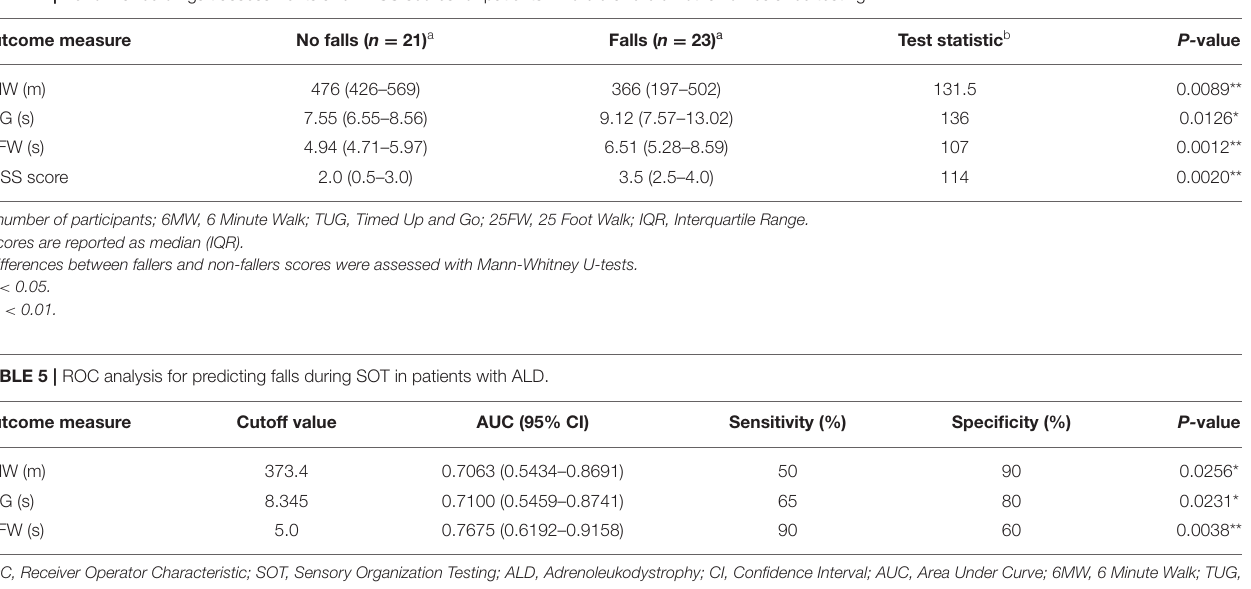
TABLE 4 | Performance on gait assessments and EDSS scores for patients who did and did not fall on balance testing.